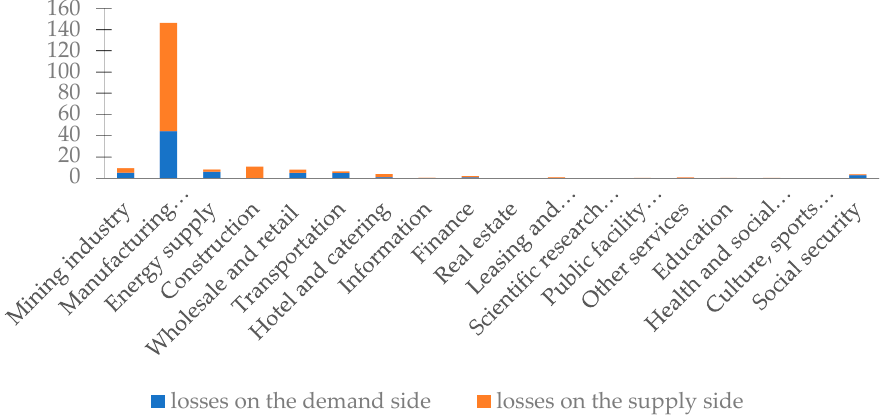
Figure 2. Indirect economic losses on the demand/supply side in Jiangxi province (unit: CNY 100